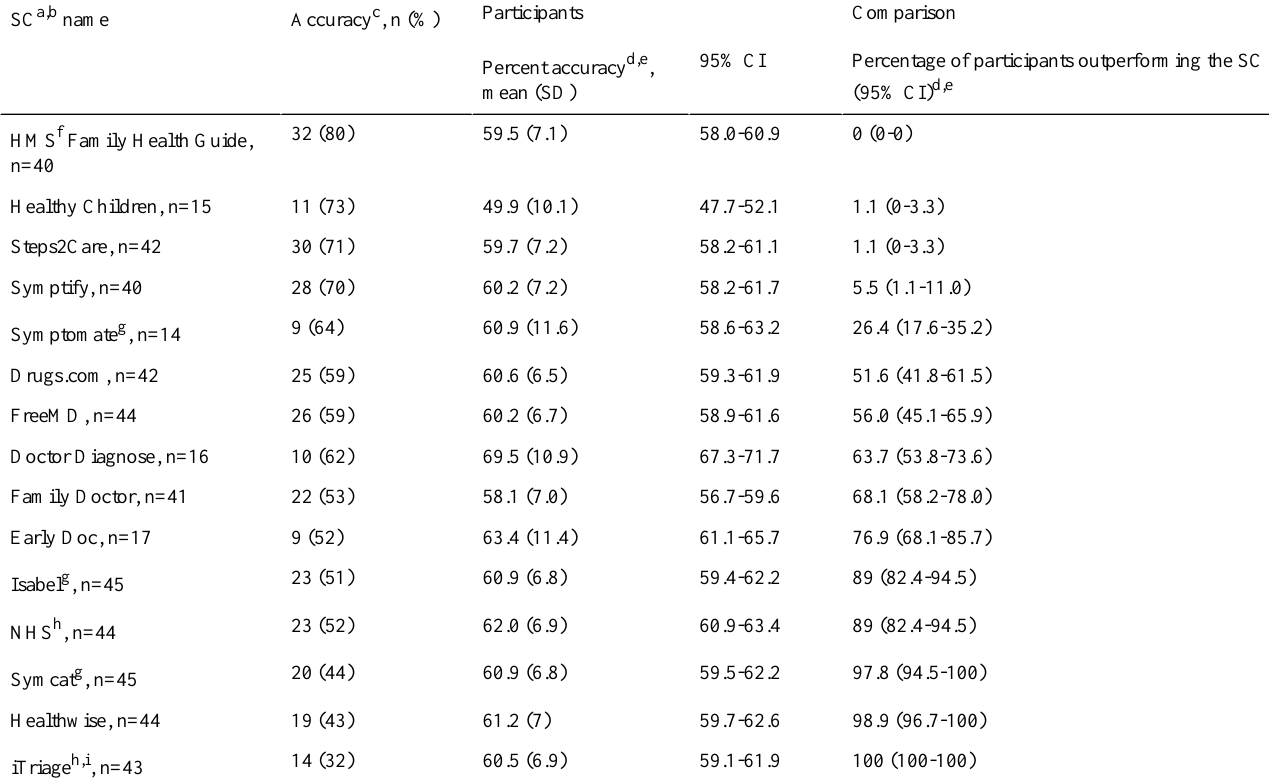
Table 3. Comparison of accuracy between symptom checkers and